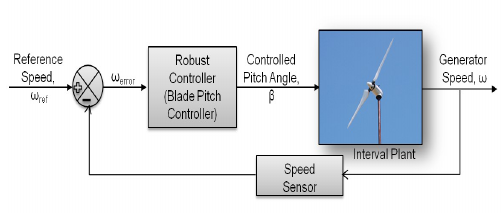
Figure 2. Feedback control of interval plant p ( s, a, b